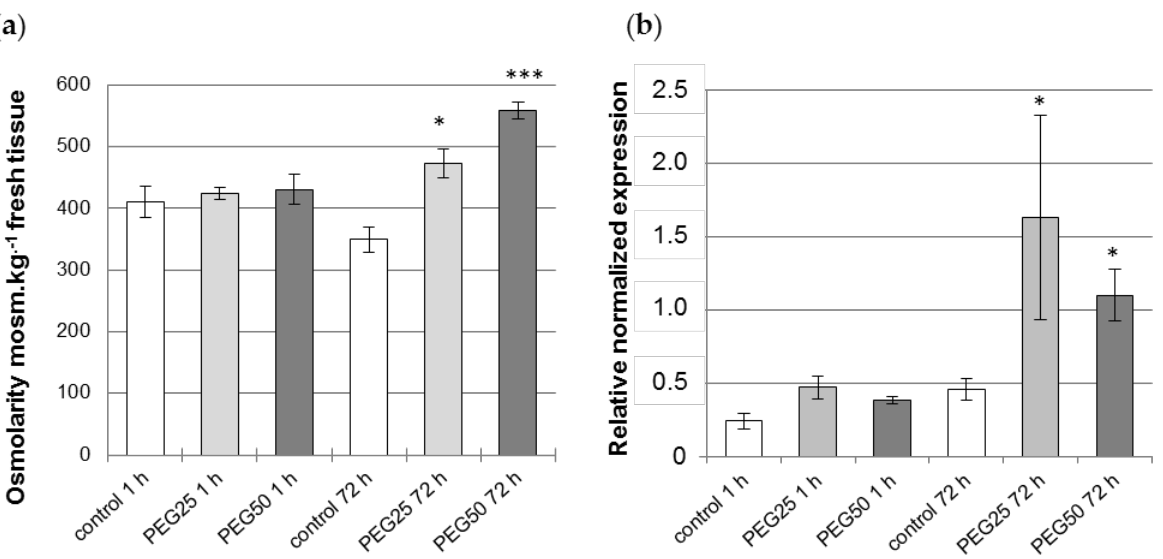
Figure 2. Physiological response of P. nigra seedlings to osmotic stress. ( a ) Osmolarity of aerial tissues (cotyledons, hypocotyl) of seedlings measured after 1 h and 72 h under control and PEG-mediated osmotic stress conditions. Mean and standard error from four biological replicates. ( b ) Transcript abundance of P5CS2 gene in the root tips of seedlings grown for 1 h and 72 h under control and PEG-mediated osmotic stress conditions. Relative transcript levels of P5CS2 were normalized to the abundance of the reference genes ( YSL8 and PDF2 ) transcripts. Mean ± standard error from three biological replicates. * and *** indicate a significant difference with the corresponding control at level alpha = 0.05 or 0.0001, respectively, according to a Kruskal–Wallis test with Dunn’s